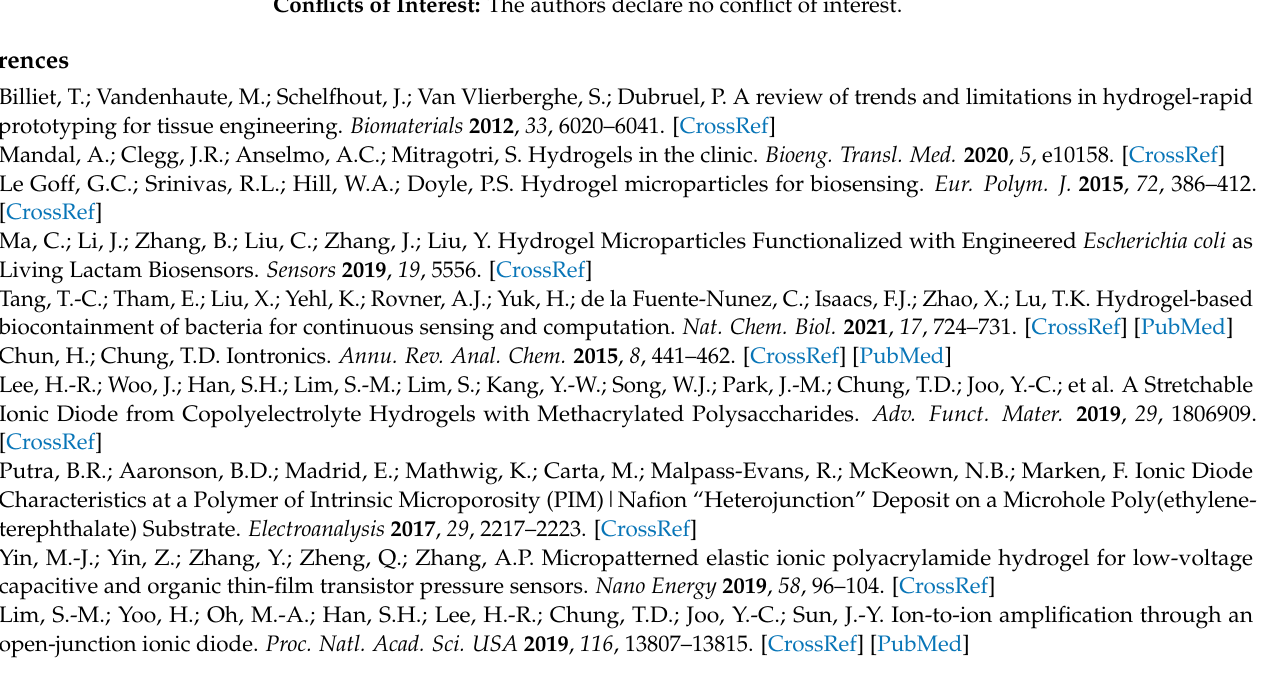
Schematic illustration of the symmetric 2D computational domain, Table S1: Boundary conditions Table S1: Boundary conditions for the 2D axial symmetric computational domain in Figure for the 2D axial symmetric computational domain in Figure S1.